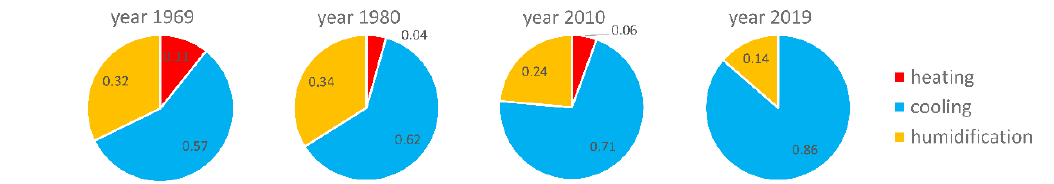
Figure 11. Share of energy for air treatment steps in total energy demand, t sup 2 = 12 °C.